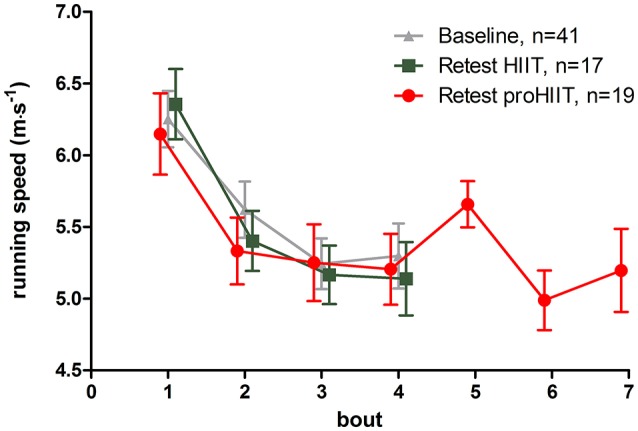
Running speed during high-intensity runs. Running speed was continuously recorded during high-intensity runs at baseline and retest to monitor exercise intensity. No significant differences in running speed at baseline and retest or between groups (bout 1–4) was detected.